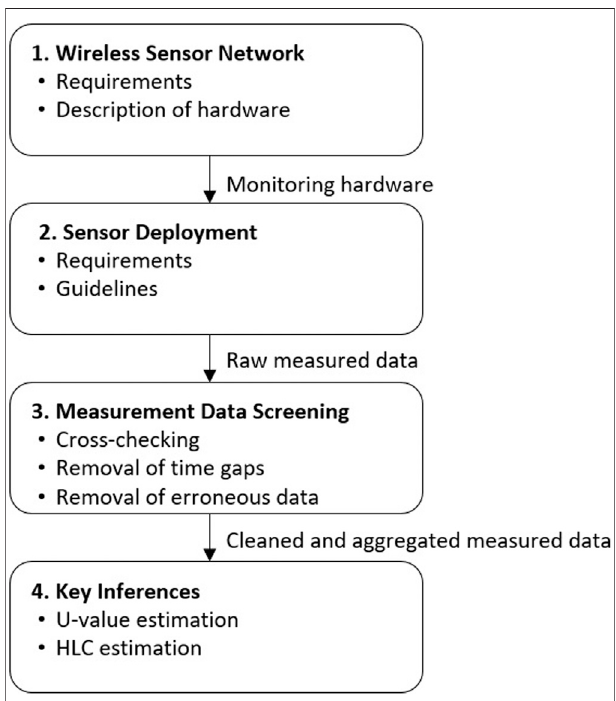
FIGURE 1 | Flow chart of a building performance assessment process using